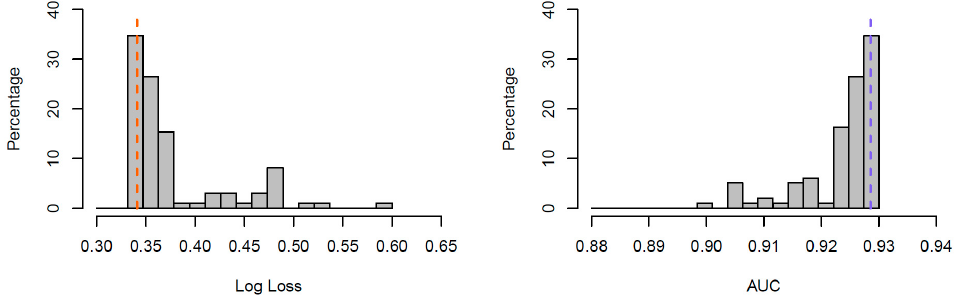
Figure 4. Percentage distribution of the performance metrics—log loss and area under curve (AUC)—across all models trained and validated during parameter tuning. The dashed vertical lines indicate the performance of the best model selected (left: log loss; right: AUC).